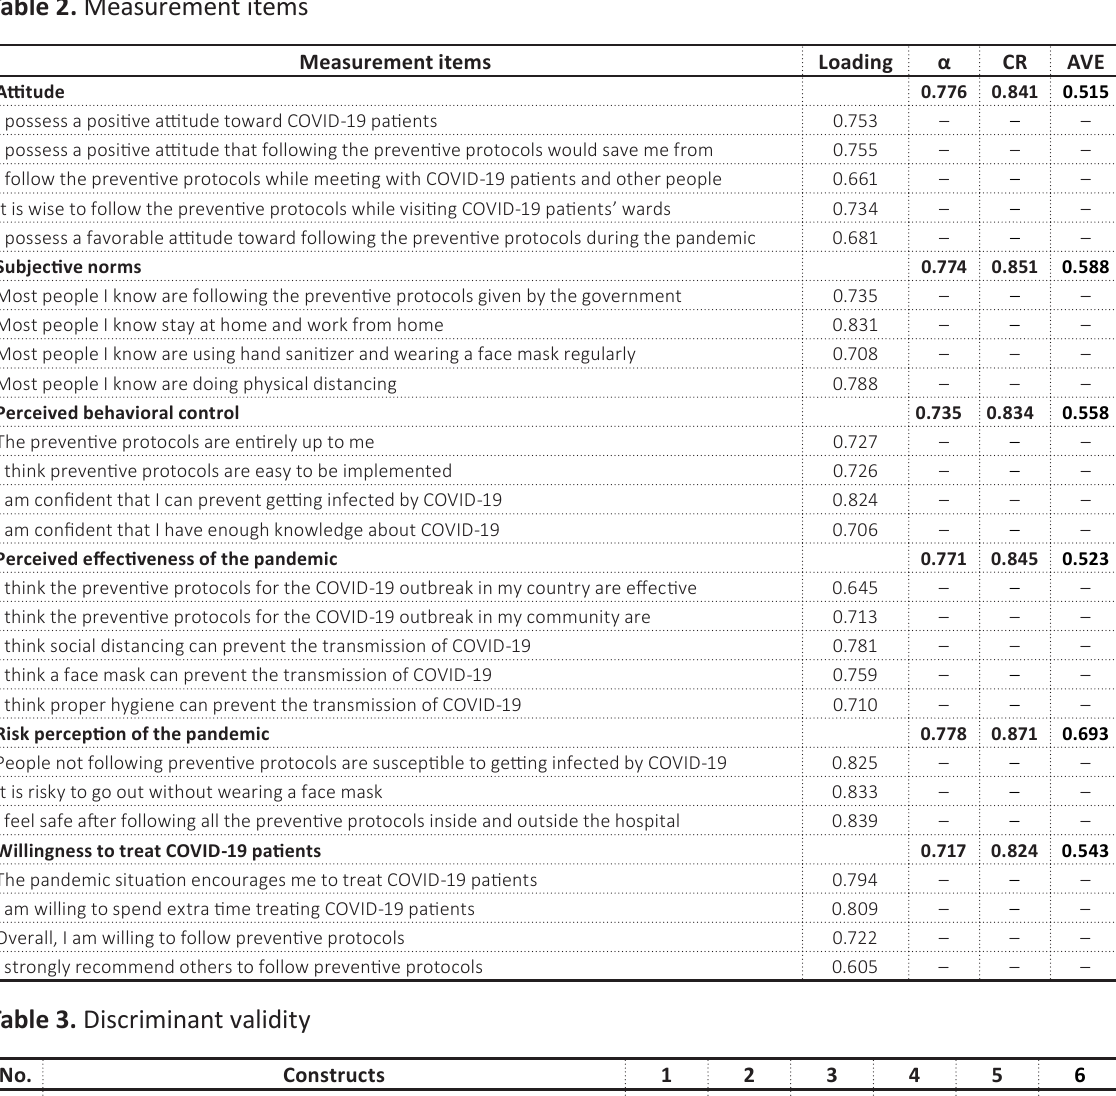
Table 2. Measurement items